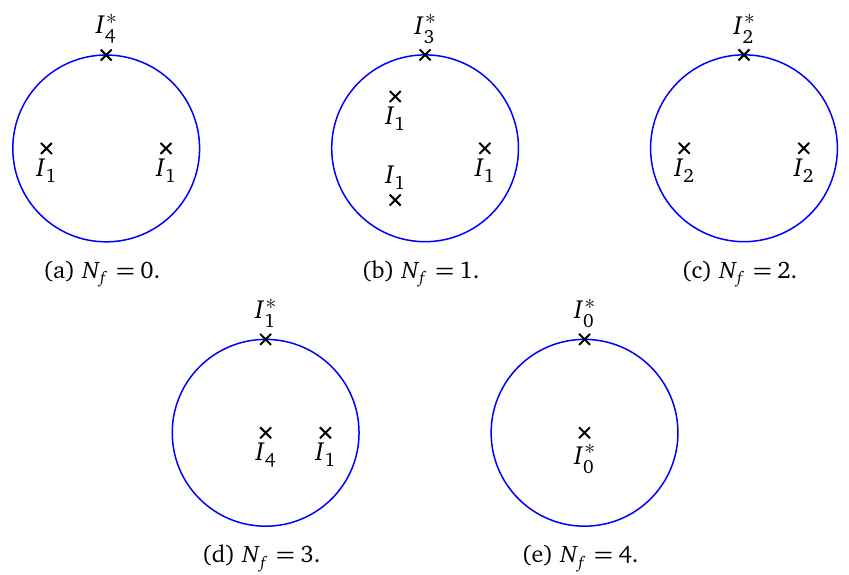
Figure 3: The u -plane of 4d N = 2 SU ( 2 ) with N